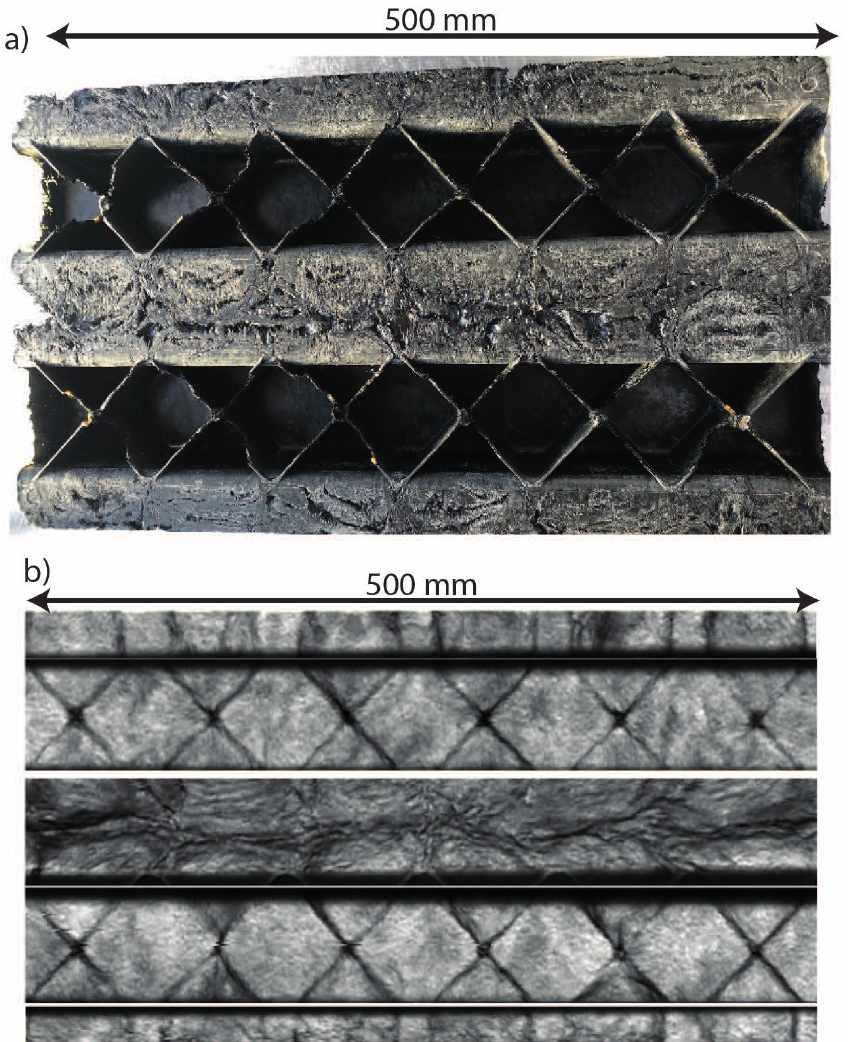
Figure 17. ( a ) A photo of a partially filled 3D structural CFRP part containing two characteristic “u-profile beams”. ( b ) EC real raw image obtained from the outer surfaces of a fully moulded twin characteristic “u-profile beam” 3D part with an underlying internal rib